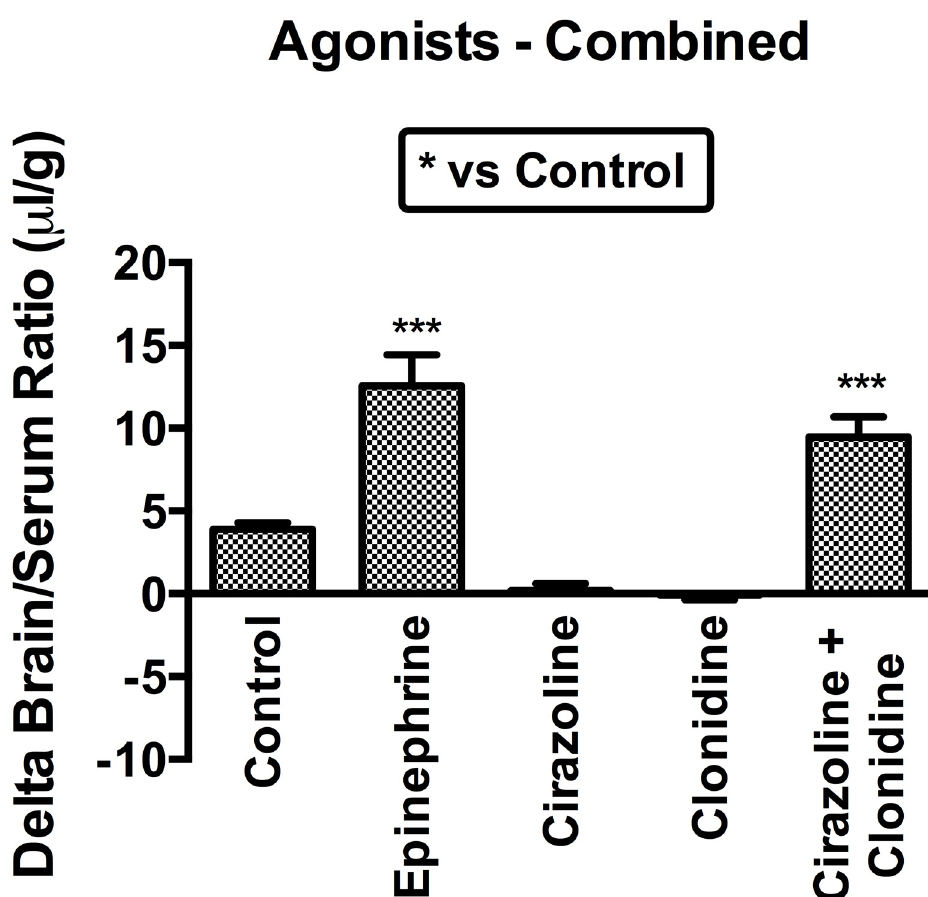
Fig 5. Combined effect of alpha1 (cirazoline) and alpha2 (clonidine) adrenergic receptor agonists on I-PGUS transport across the BBB. Neither drug alone affected I-PGUS uptake, but combined they effectively increased transport across the BBB. *** p < 0.001 in comparison to control; n =